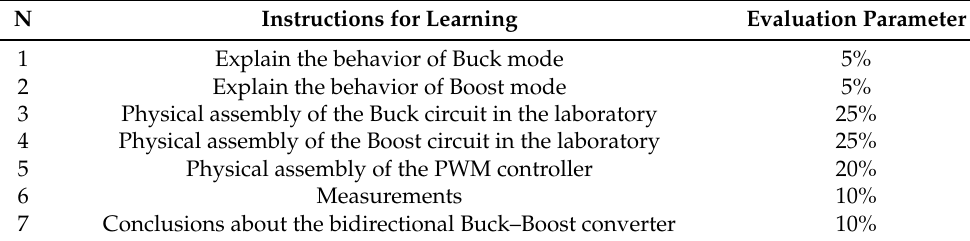
Table 8. Evaluation rubric for Buck–Boost